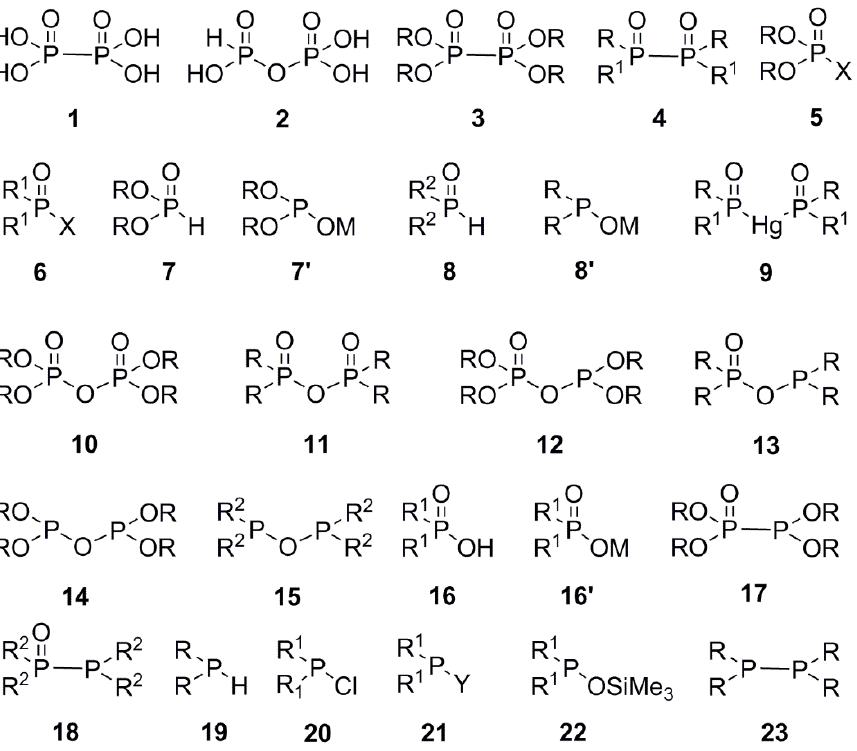
Figure 1. The general structures of presented molecules (R = Alkyl, Aryl; R 1 = R or RO; R 2 = R or N R 2 ; Y = NR 2 or TFA).